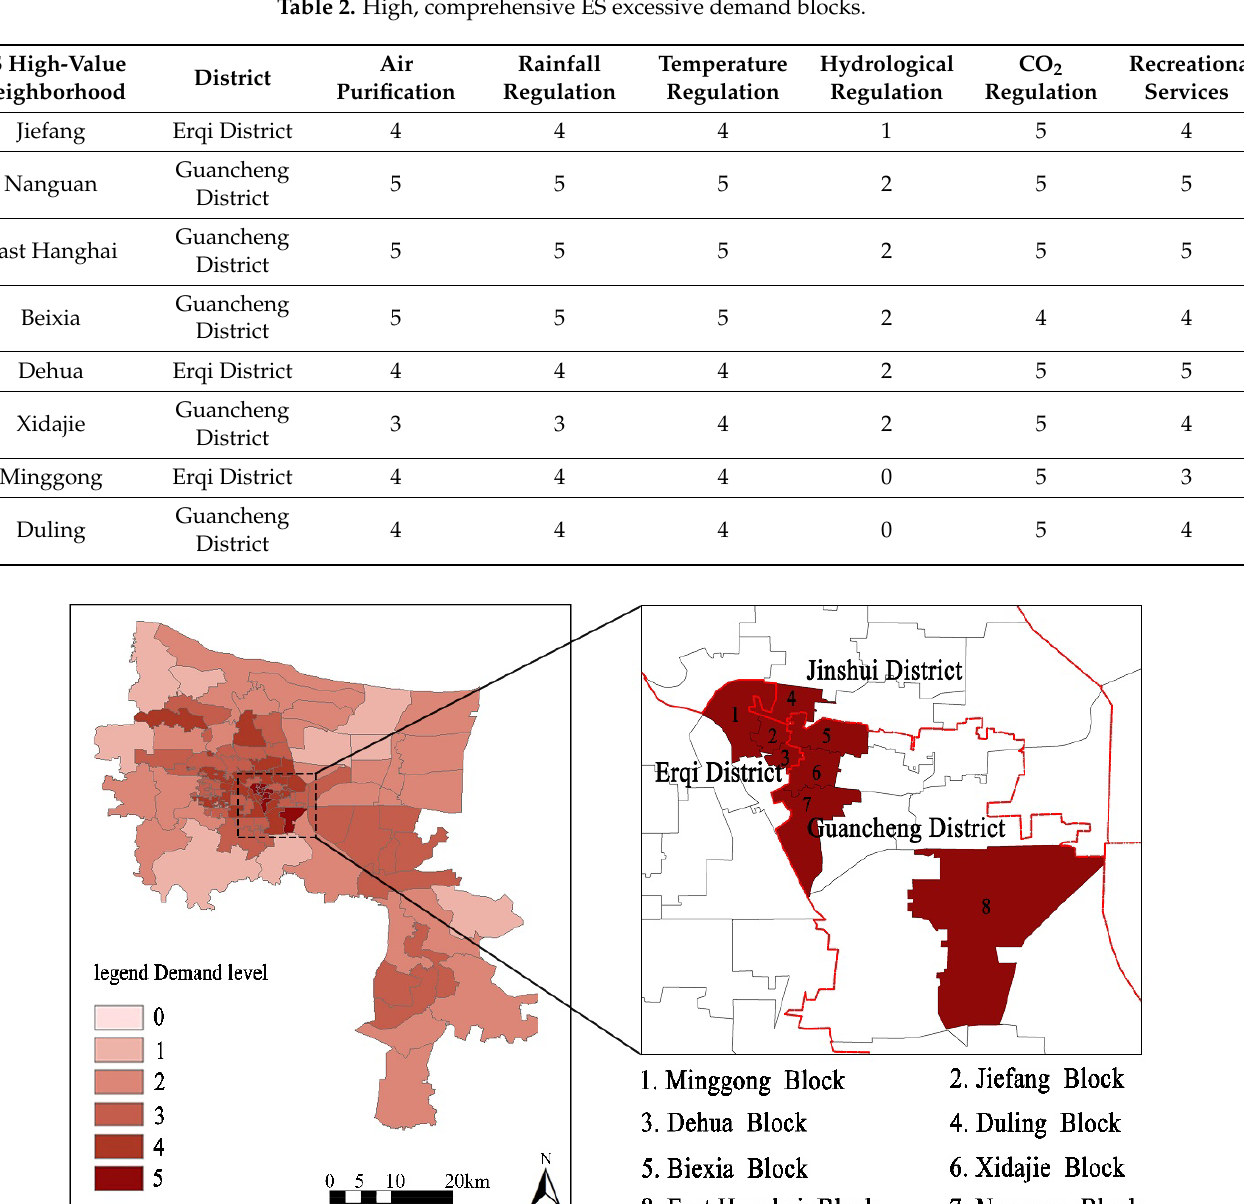
Figure 3. Evaluation of the comprehensive excessive demand for UESs.